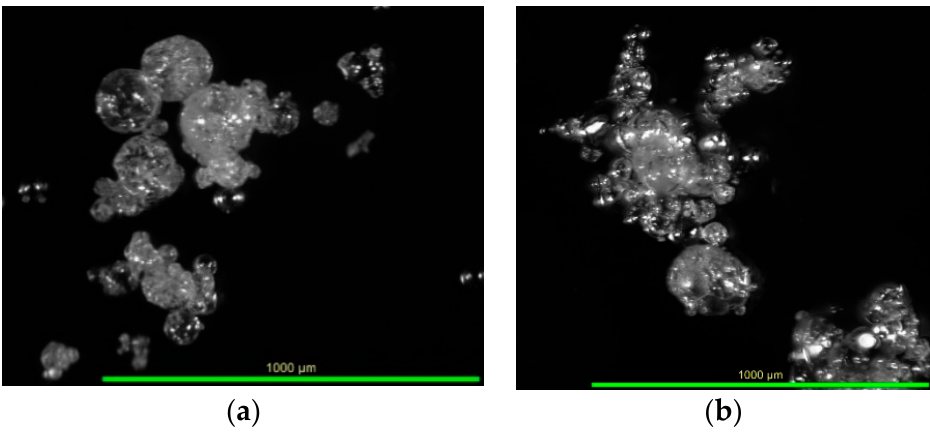
Figure 7. Product photos from the stereoscopic microscope for the nozzle at the top position ( a ) and bottom position ( b ) (adapted from Ref. [33]).